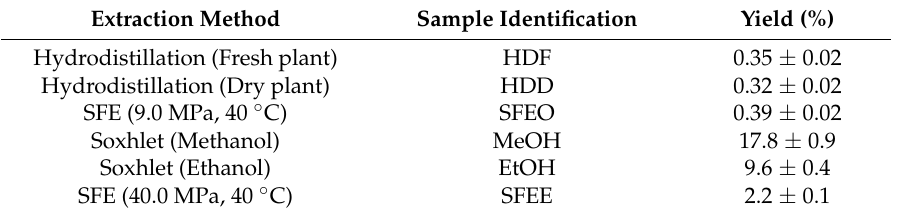
Table 1. The extraction yields from basil ( Ocimum basilicum L.) using different extraction